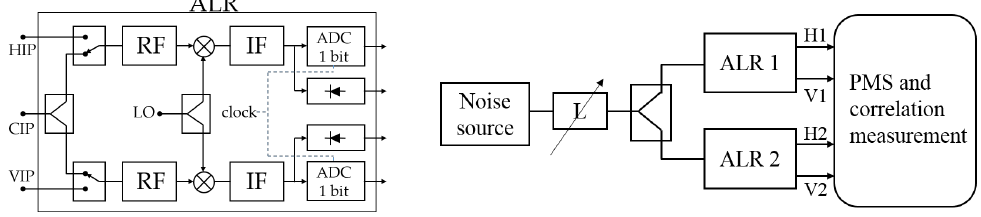
Figure 5. Left: Simplified block diagram of an Advanced Receiver for the Future L-Band Radiometer (ALR). Labels HIP, VIP, and CIP refer respectively to the Horizontal, Vertical, and Calibration Input Planes. The additional position of the input switch to a matched load and IF switched attenuation, needed for offset measurement, are not shown for simplicity. Right: Test bench to measure the cross-correlation and power of a baseline formed by two ALR